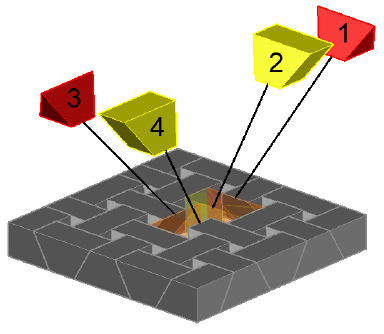
Figure 27. The order of entering parts of the keystone into the square vault.